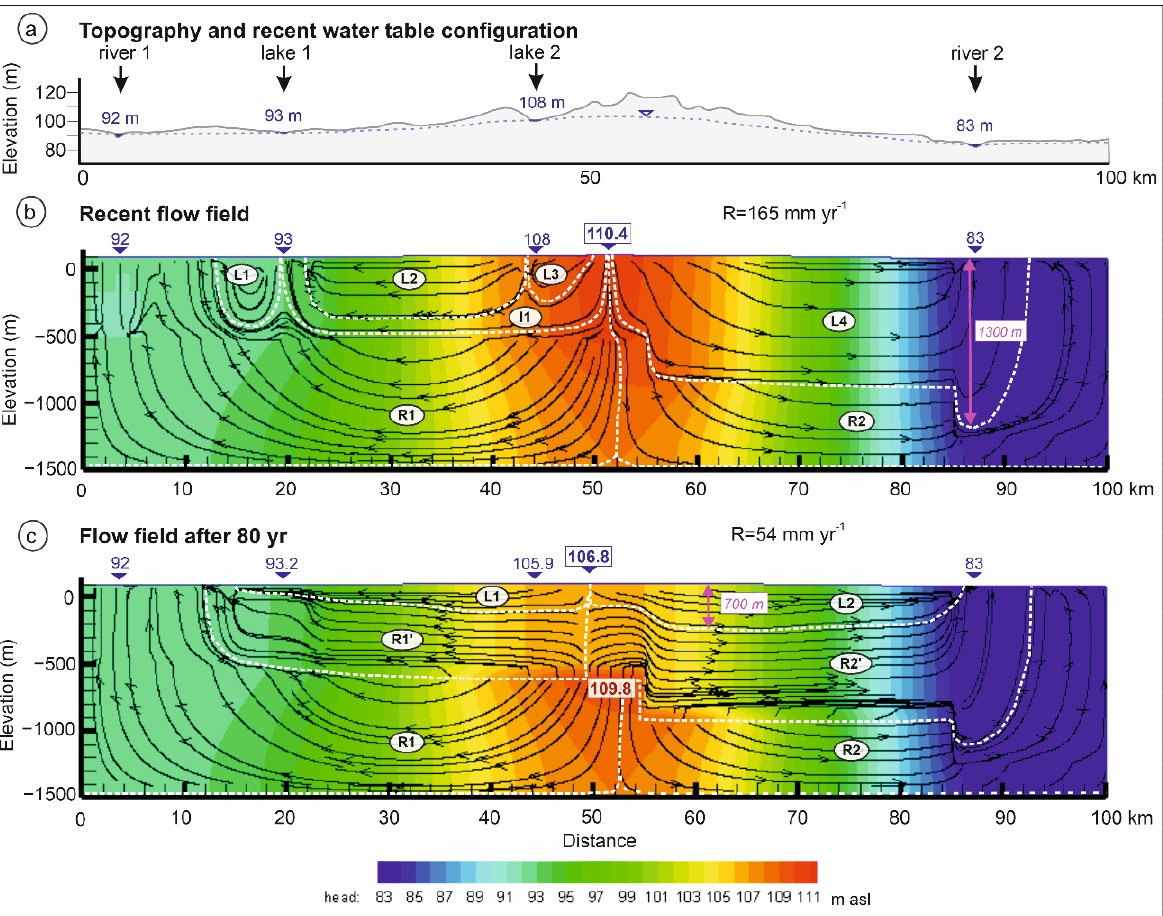
Figure 3. Results of the simulation of gravity-driven flow neglecting upward overpressure flow showing ( a ) recent groundwater table configuration in relation to the topography, ( b ) the steady-state hydraulic head distribution and flow patterns generated by the recent groundwater table topography and ( c ) the quasi-steady-state hydraulic head distribution and flow pattern after 80 yr obtained from transient simulation. Hydraulic head values are colour-shaded; groundwater flow directions are indicated by black arrows; dark blue numbers represent the surface water levels (m asl); dark blue bold number in rectangle represents the maximum hydraulic head along the water table (m asl); red bold number in rectangle showing hydraulic head maximum within the flow field (m asl); and dashed lines show the boundaries of different flow systems: L1, L2, L3, L4 are local, I1 is intermediate, R1, R1 ′ , R2, R2 ′ are regional flow systems. Purple arrows with number in rectangle showing the maximum penetration depth of the upper gravity-driven flow system. “R” represents actual recharge at the corresponding time. Distances between streamlines are not proportional to water flux. For boundary conditions see Figure 2b. Cross-section has 13× vertical exaggeration.